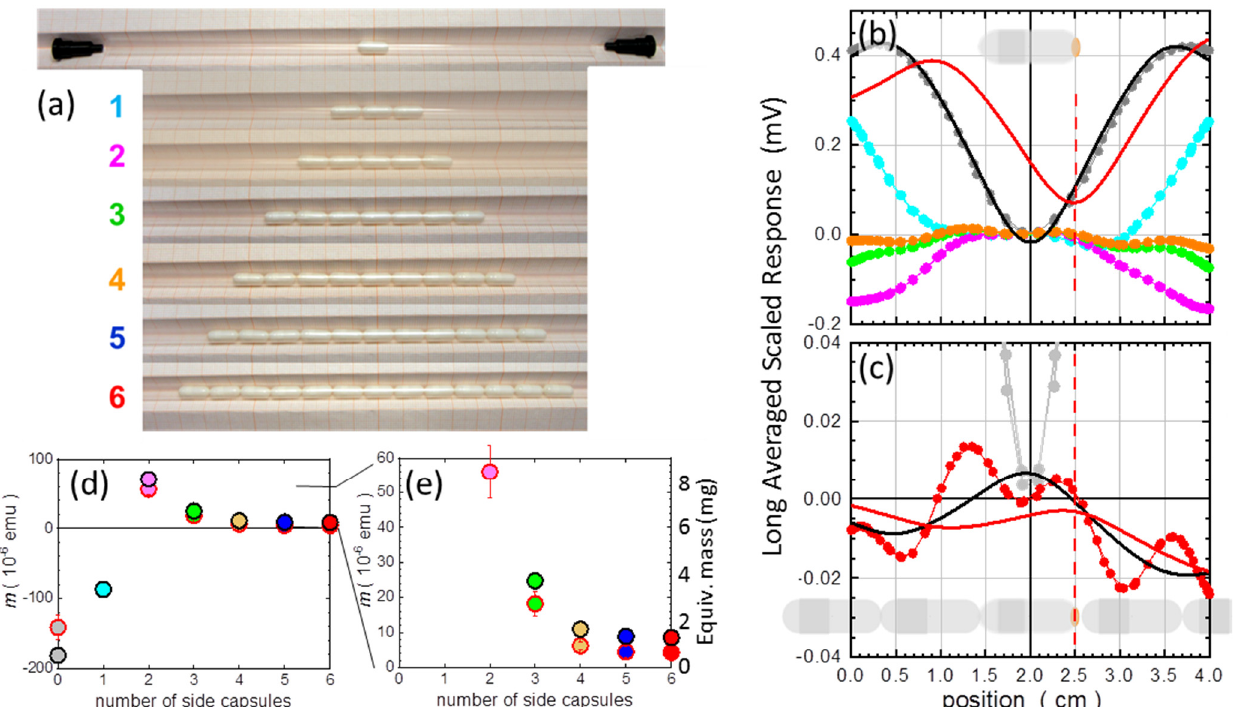
Figure 8. ( a ) The illustration of the step-by-step assembly (subpanels 1–6) of an in situ capsule compensational sample holder from capsules of size 5 and an S2 straw, that is, a straw with its diameter reduced below the external diameter of the capsules. White-colored #5 gelatin capsules are used for increased visibility only. Results presented in the rest of the panels are obtained for transparent polycrystalline capsules, as presented in Figure 7. ( b , c ) SQUID scans recorded for a single central capsule (grey symbols) and 1st, 2nd, 3rd, 4th, and 6th stages of the assembly (symbols of matching colors to the numerical markers in panel ( a )). The black vertical line represents the position of the midpoint of the capsule in the scanning window of SQUID magnetometer and the red dashed one the position of the bottom of the capsule. The black and red wavy curves represent the SQUID response function (SRF) centered at these two locations. In panel ( b ) the fitting is done to the dataset corresponding to a single capsule, in panel ( c ) to the 6th stage of the assembly (red symbols). The fitting approach is described in Appendix B. ( d ) Results of the fits to the scans collected in every stage of the assembly (magnetic moment m ). The fill color of each circle corresponds to the assembly stage, whereas the edge color (black or red) correspond to color marking of the alignment of the SRF: at the center of the central capsule or at its bottom, respectively. ( e ) The blown-up part of panel ( d ) for increased resolution near zero for the last stages. The added right Y-scale expresses the degree of the compensation in an equivalent mass of the central capsule of a mass of 30 mg.